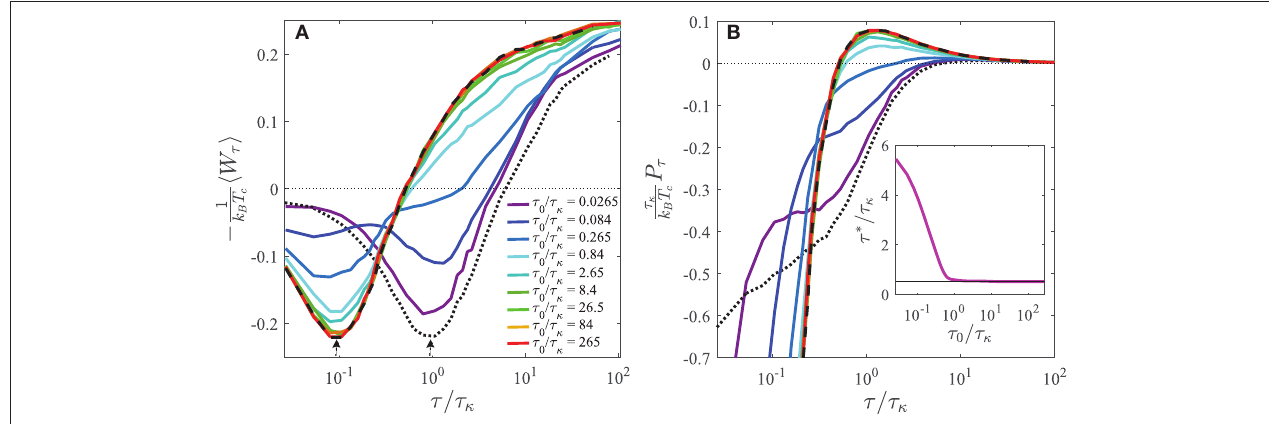
W τ FIGURE 3 | (A) Mean work done by the Brownian Stirling engine during a cycle, , as a function of the cycle time τ , for different values of the fluid relaxation time −h i τ 0 (solid lines). The dotted and dashed lines represent the mean power output of a Brownian Stirling engine in Newtonian fluids with constant viscosities η η α ) − 1 η 0 η (1 , respectively. The arrows depict the location of the corresponding minima. (B) Mean power output per cycle of the colloidal Stirling engine, P τ , = = + ∞ as a function of the cycle duration τ , for different values of the fluid relaxation time τ 0 (solid lines). The dotted and dashed lines represent the mean power output of a η 0 and η α ) − 1 η 0 η Brownian Stirling engine in Newtonian fluids with constant viscosities η (1 , respectively. Same color code as in (A) . Inset: stall time of the = = + = ∞ engine defined in Equation (26), τ ∗ , as a function of the fluid relaxation time, τ 0 (thick line). The thin line represents the value of τ ∗ for an engine operating in a η Newtonian fluid with constant viscosity η = ∞